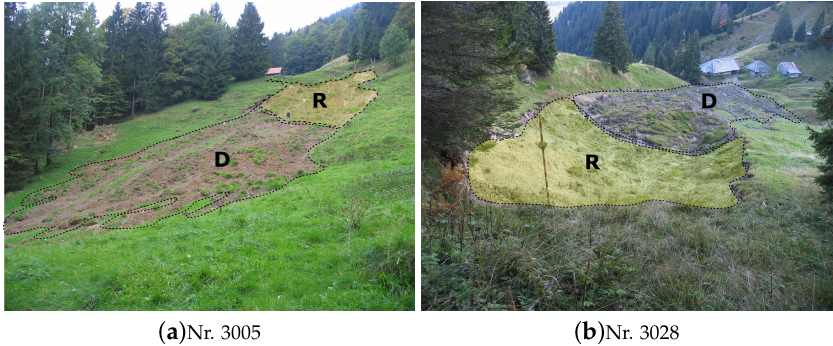
Figure 1. Release area (R) and deposition zone (D) of two of the documented hillslope debris-flow events used for this study [42]. A transition area is not clearly identifiable. Both events occurred in 2005 in Entlebuch (Canton of Lucerne,